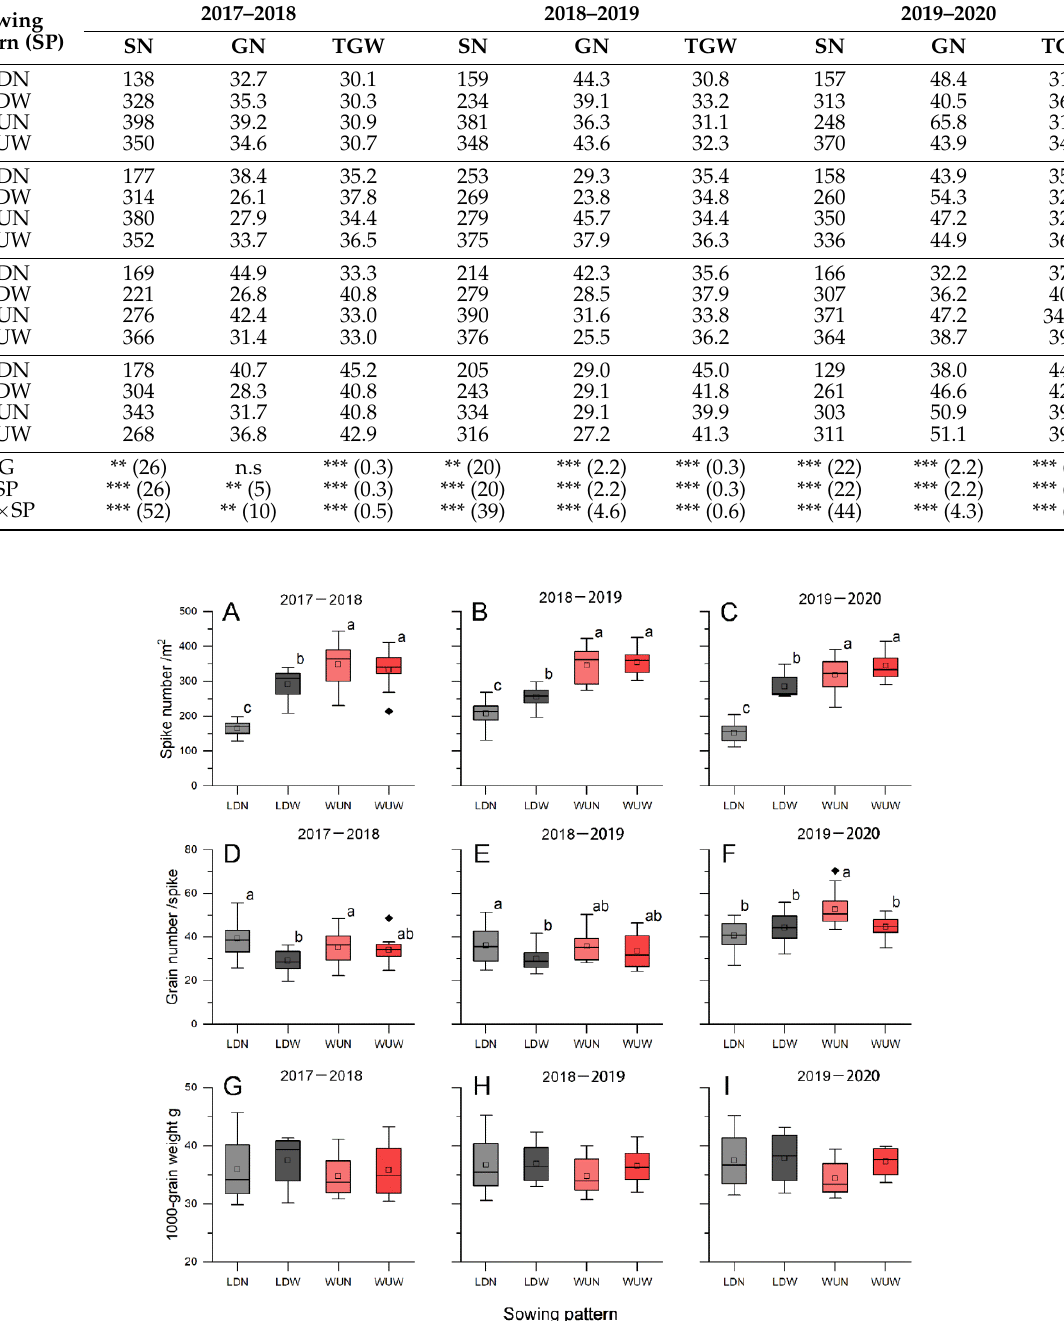
Table 3. The spike number (SN), grain number (GN) per spike and 1000-grain weight (TGW) of four wheat genotypes under four different sowing patterns during three consecutive growing seasons. LSD values at p = 0.05 are in parenthesis. n.s not significant, ** p < 0.01, *** p < 0.001.